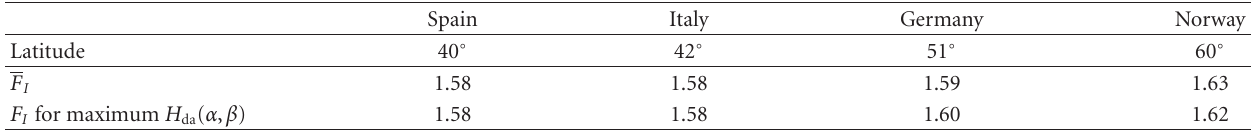
Table 3: Current factor mean value for di ff erent European locations and value for orientation maximising the annual irradiation received by the cell.